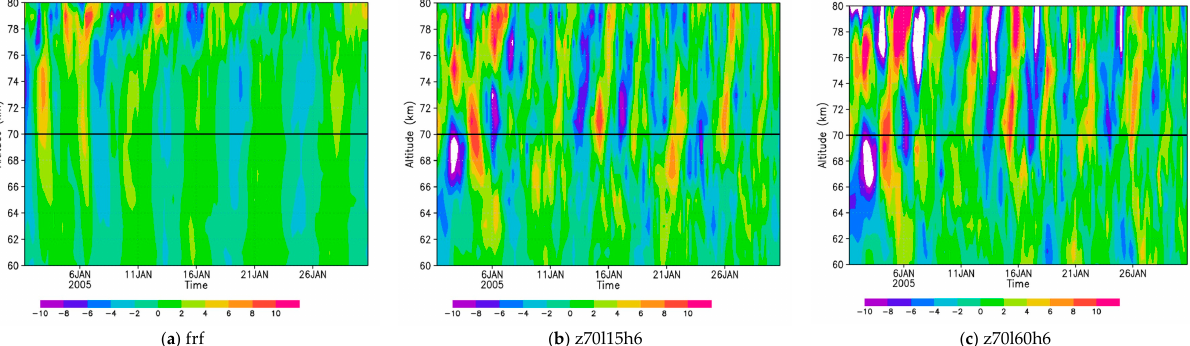
Figure 3. Time-altitude cross sections of zonal wind deviation from its 10-day running mean at the equator from 1 January 2005. Data is not assimilated in ( a ), namely, free run forecast of AFES-Venus, while it is assimilated (analysis) each 6 h at 70 km altitude from 15 ◦ S–15 ◦ N in ( b ) and from 60 ◦ S–60 ◦ N in ( c ). Black lines clarify an altitude of 70